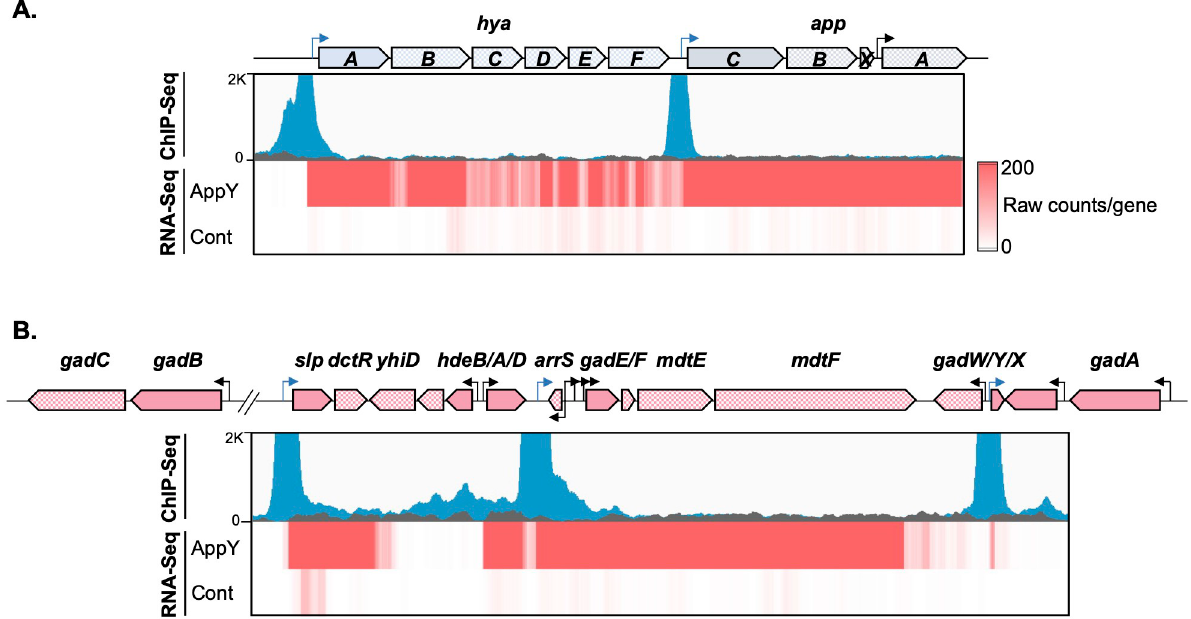
Fig 2. Identification of AppY binding sites by ChIP-Seq experiments. MG1655 Δ rpoS strain containing the plasmids pQE80L, pQE80L- appY -3Flag or appY K170E -3Flag were grown at 37˚C to an OD 600 * 0.2 and appY expression was induced with 0.05 mM IPTG for 1 hour. The genetic loci, the ChIP-Seq data obtained with AppY-3Flag and AppY K170E -3Flag and the gene expression profiles obtained by RNA-Seq with AppY or the vector control are shown from the top to the bottom. In the genetic loci, genes with plain colour are located immediately downstream of a promoter; other genes are hatched. Peaks observed in ChIP-Seq with AppY WT (blue) or AppY K170E (black) are superimposed for comparison; the intensity of the red color in RNA-Seq panels represents the number of raw counts per gene. The data are representative of three independent experiments. A. Regulation of the hya and app operons. B. Regulation of the acid fitness island. The promoter regions where AppY binds are represented by blue arrows. gadE expression depends on four different promoters; AppY binds to the P3 promoter, the farthest from gadE start codon.